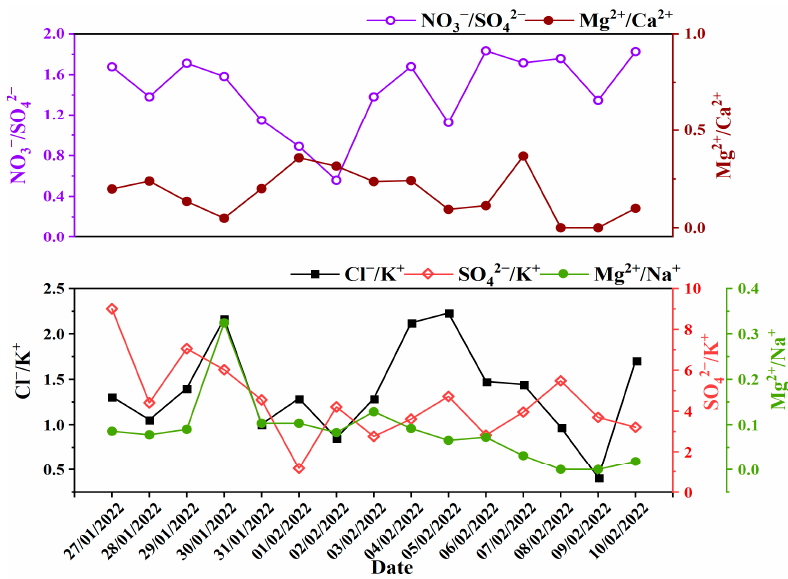
Figure 9. Distribution of multiple ion